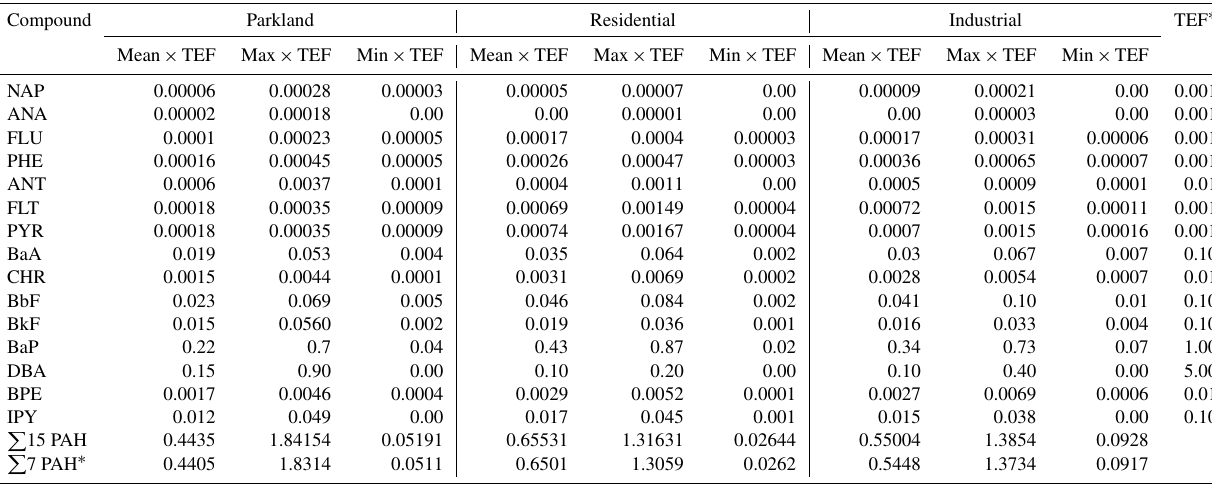
Table 6. PAH concentrations in urban soils, expressed in BaP eq , mgkg − 1 . Compound Parkland Residential